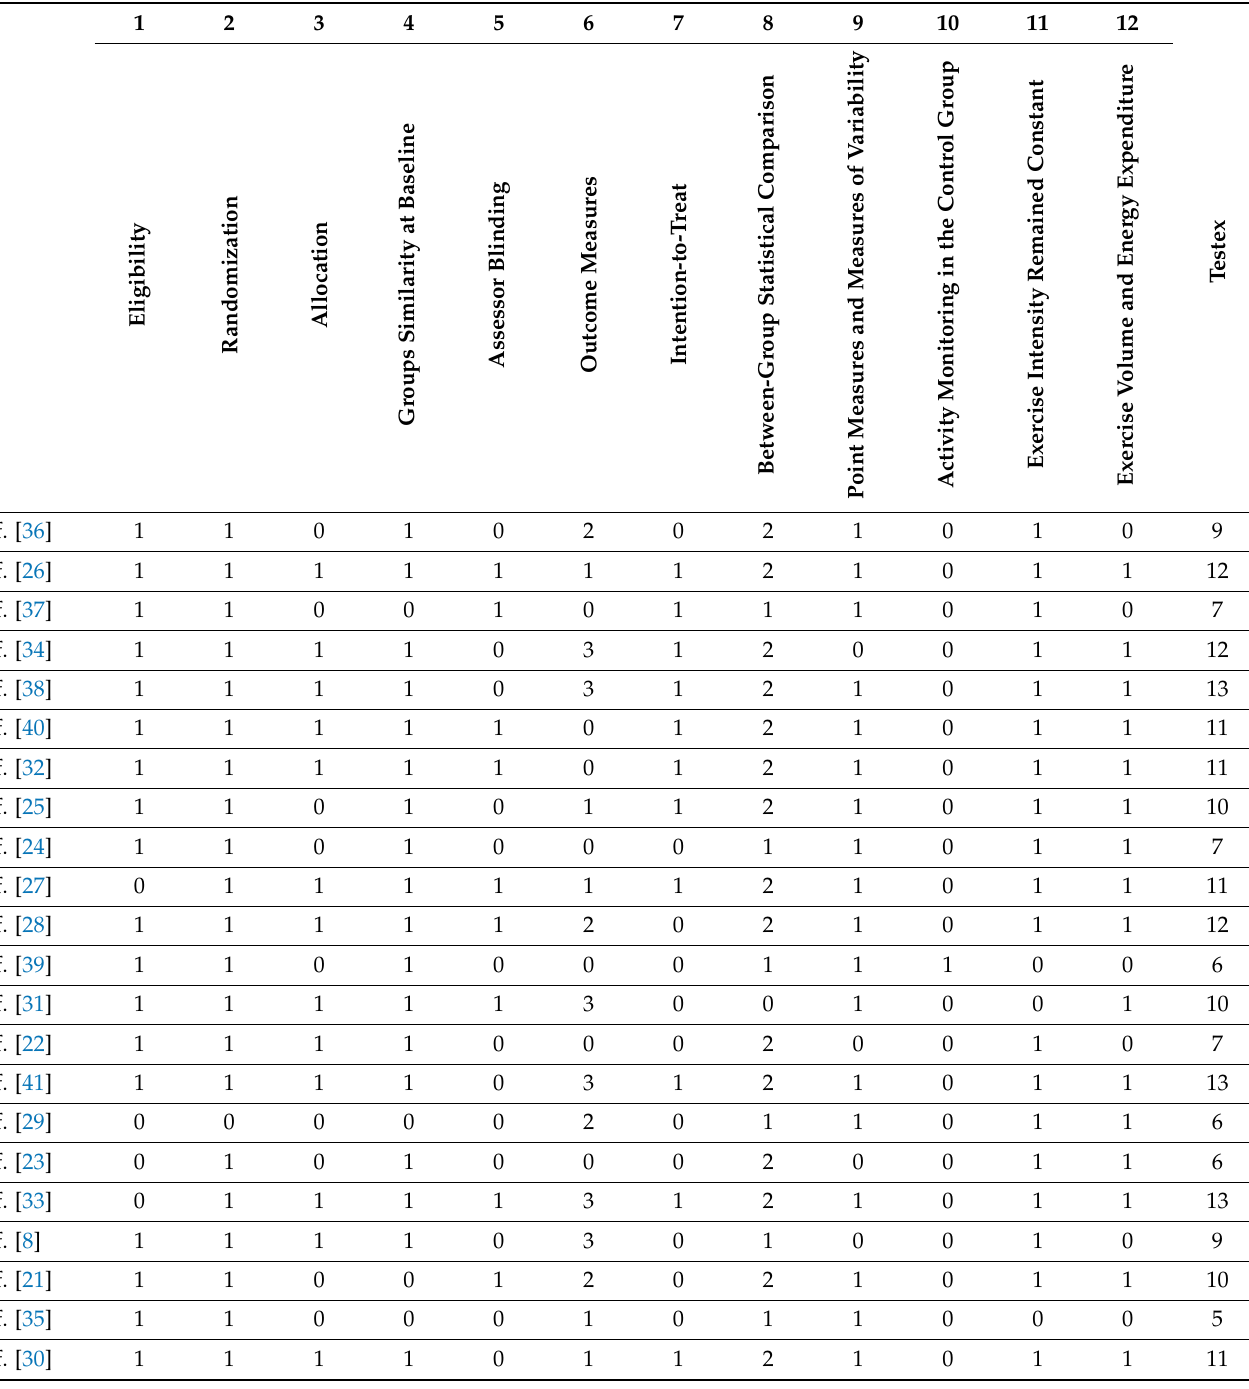
Table 1. The Tool for the assEssment of Study qualiTy and reporting in EXercise (TESTEX) scale score for each study was included in the systematic